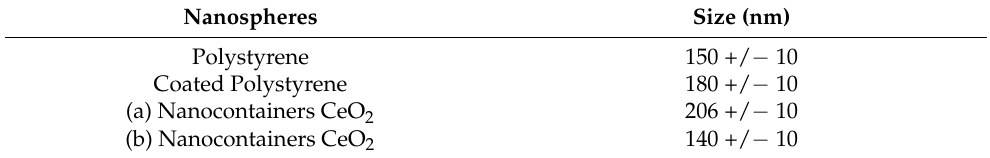
Table 3. Nanosphere sizes after the first (Figure 2a) and second (Figure 2b) heat treatment at 600 ◦ C.